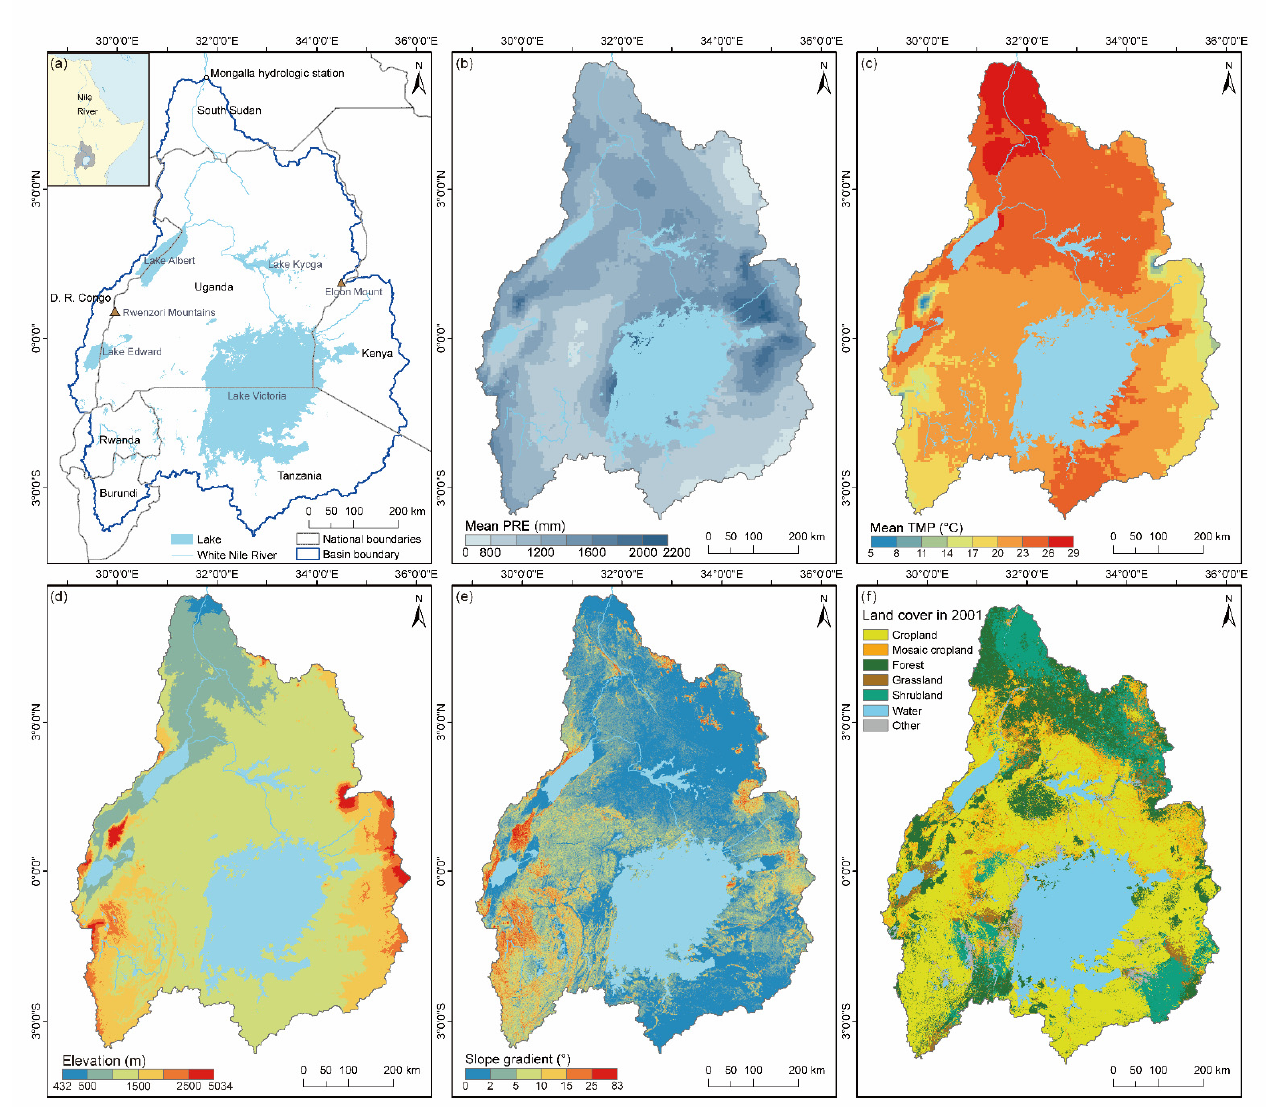
Figure 1. Schematic diagram of the basic information space of the UWNR. ( a ) Location map. ( b ) Mean PRE. ( c ) Mean TMP. ( d ) Elevation. ( e ) Slope gradient. ( f ) Land cover in 2001.